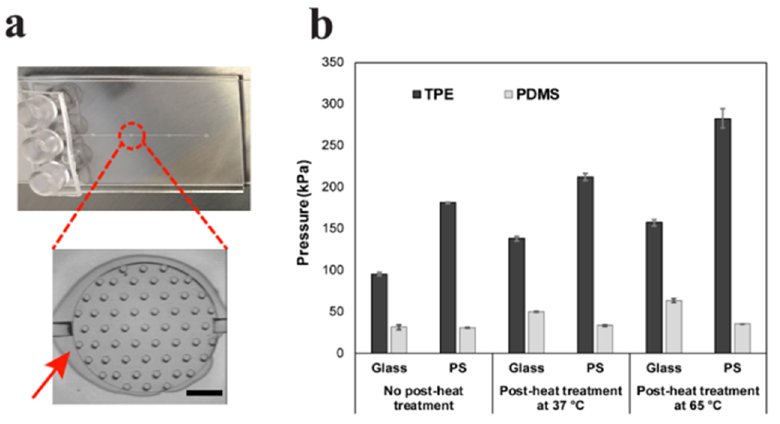
Figure 2. TPE Bonding test device and delamination pressure under different conditions. ( a ) A photograph of an assem- bled device for delamination testing. The zoomed-in image shows in the area of an array of micropillars. A representative microscopy image shows a fully delaminated TPE chamber on the glass slide as the applied pressure is increased. A red arrow bar indicates a delaminated area. The scale bar represents 200 µm. ( b ) A comparison bar graph of bonding strengths